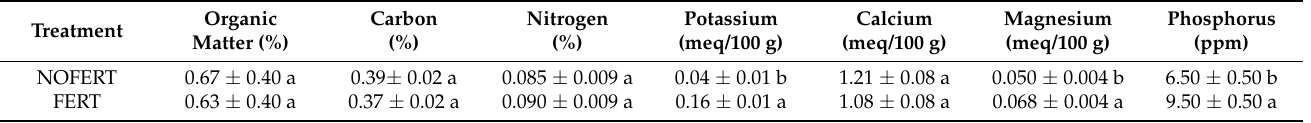
Table 4. Soil properties (mean ± SE) during the 2018 NOFERT and FERT treatments. Treatments with different letters are significantly different using an ANOVA test, α = 0.05.